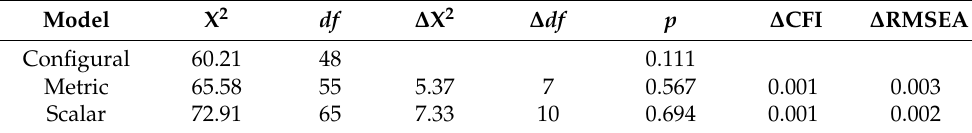
Table 7. Results of comparison across calibration ( n = 430) and validation sample ( n = 430)